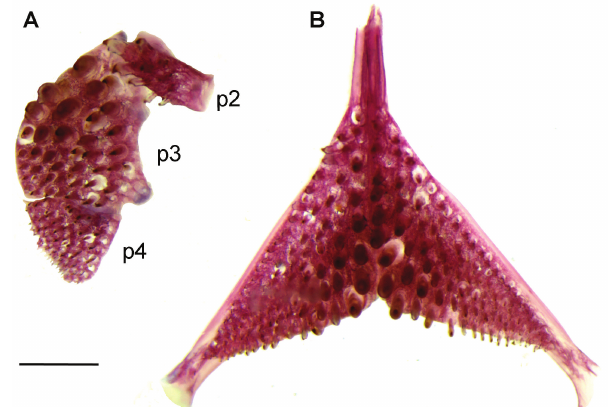
Fig. 5 . Pharyngeal jaws of a 54.8 mm SL Gymnogeophagus terrapurpura paratype (ZVC-P 7060); (A) Ventral view of left upper pharyngeal jaws; (B) Dorsal view of lower pharyngeal jaws; p2-4 = pharyngobranchials 2-4. Scale bar = 1 mm. Table 2. Morphometric data of Gymnogeophagus terrapurpura , G. meridionalis , and G. rhabdotus . Measurements expressed as percentages of standard length, except those marked with *, which are percentages of head length.